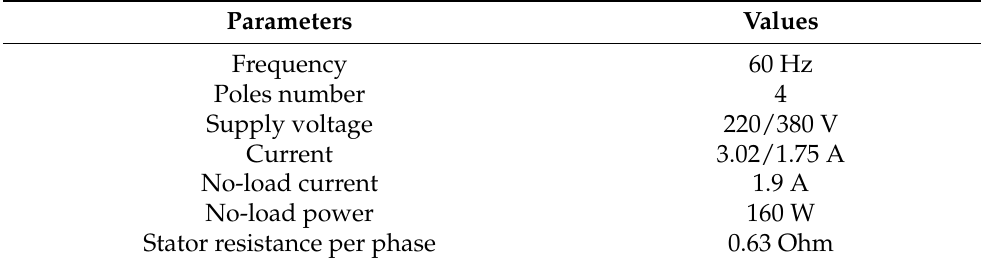
Figure 12. Split-winding bearing machine prototype. The electrical data of the machine is detailed in Table 1. Table 1. Machine